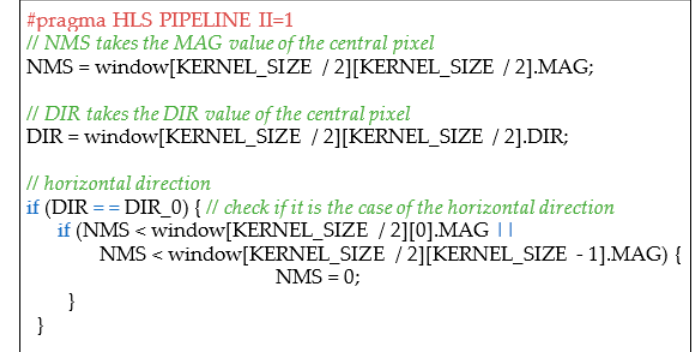
Figure 14. Excerpt of the C++ HLS description of the non-maximum suppression module.